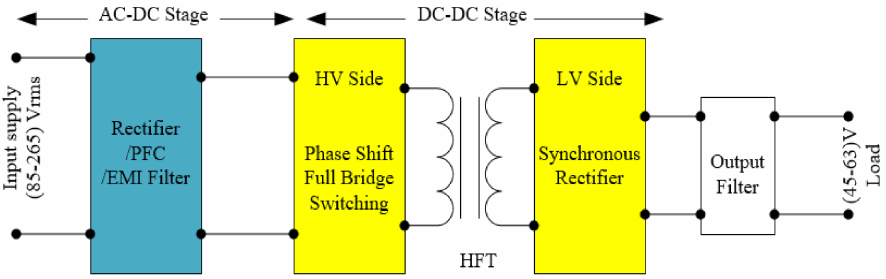
Figure 1. Block diagram of the two stages AC-DC telecom power